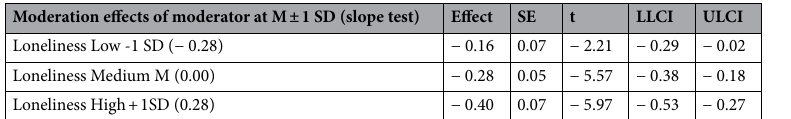
Table 4. Slope test analysis of the moderation effects of the moderator (loneliness) and quality of life as dependent variable.